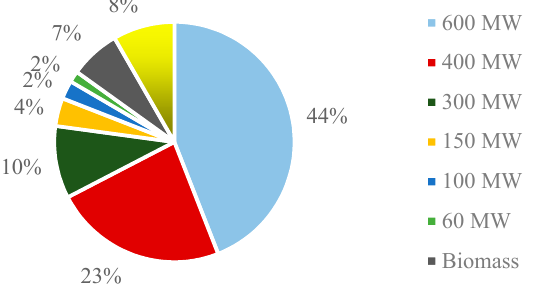
Figure 4. The generating proportion of different units.